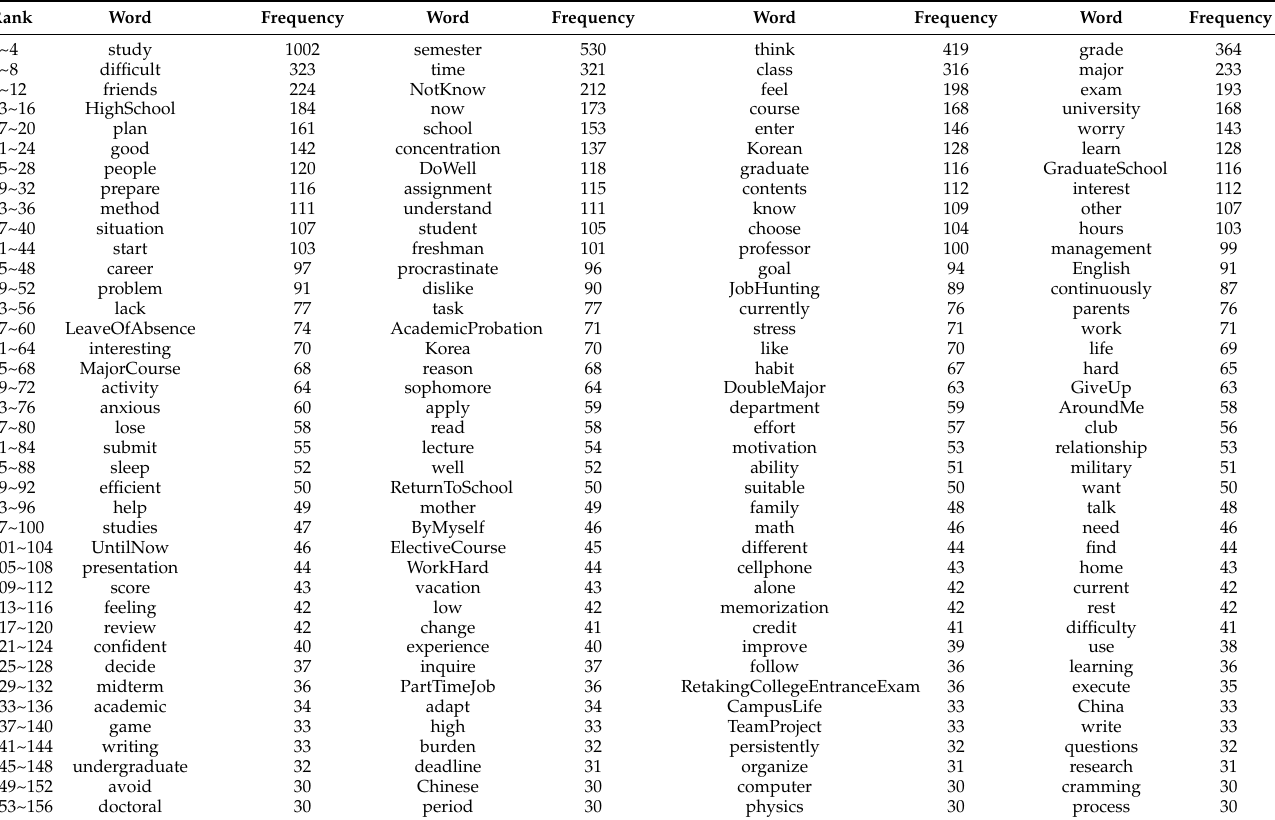
Table A1. Keywords in HSS track with frequency of 30 or more.